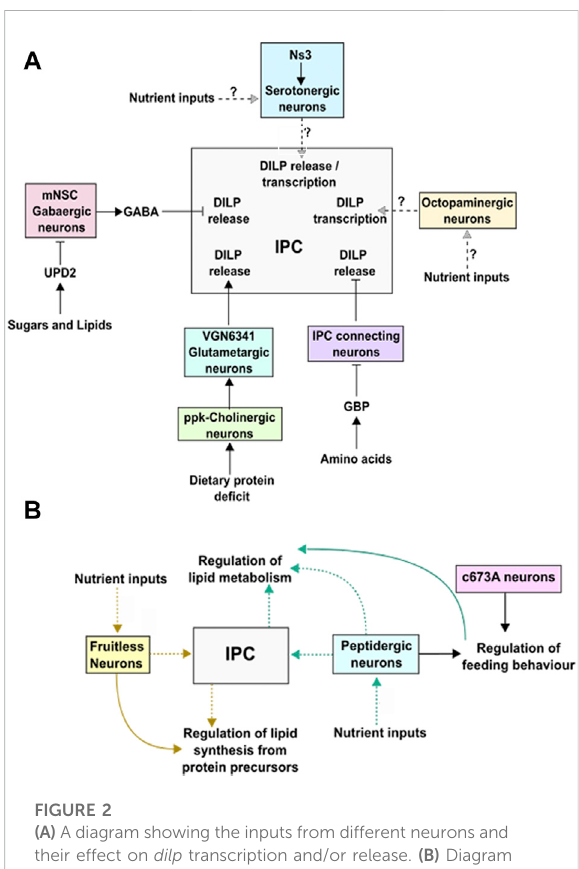
their effect on dilp transcription and/or release. (B) Diagram showing neurons associated with lipid synthesis and metabolism. The dotted lines indicates pathways that need to be